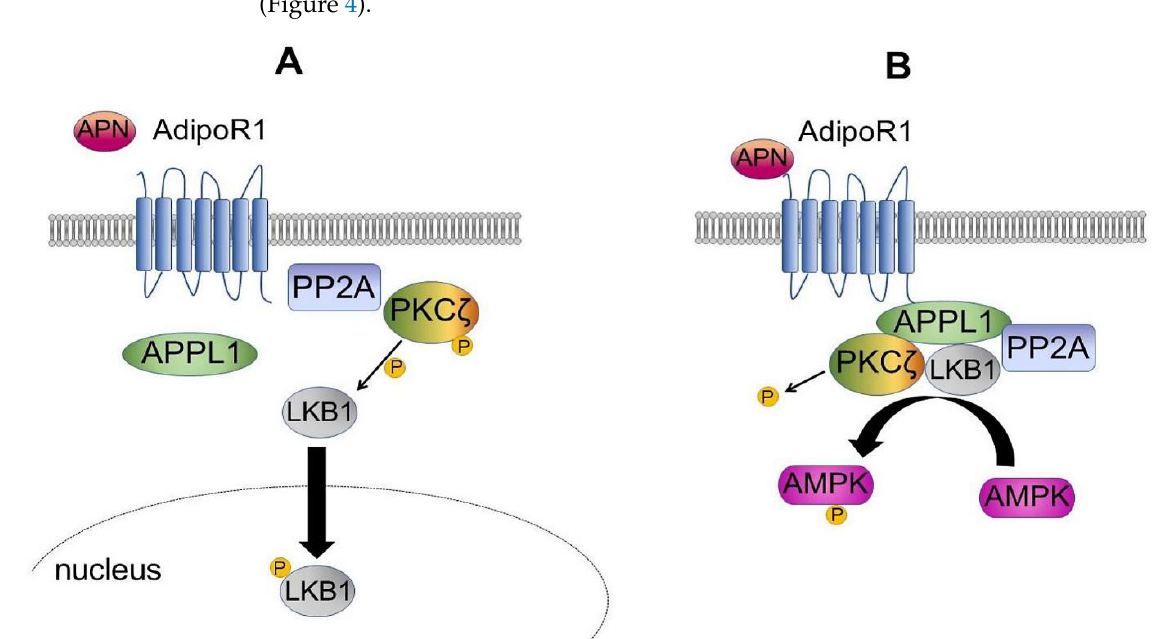
Figure 4. PVAT control vascular function by mean of precise mechanism related to adiponectin- dependent AMPK activation. Two conditions are relevant. ( A ) non-stimulated with no link between adiponectin (APN) and Adiponectin receptor 1 (AdipoR1). Adaptor protein, phosphotyrosine interacting with PH domain and leucine zipper 1 (APPL1) do not work alongside protein phosphatase 2A (PP2A). Protein kinase Cζ (PKCζ) induces phosphorylation of liver kinase B 1 (LKB1) affecting its translocation to the nucleus. ( B ) The stimulated state induces the bind of APN to AdipoR1 with activation of APPL1 resulting in PKCζ dephosphorylation by P. Dephosphorylated PKCζ is no longer effective to phosphorylate LKB1. PP2A also dephosphorylates LKB1, which results in LKB1 translocation to the cytoplasm. LKB1 phosphorylates AMP-activated protein kinase (AMPK) in the form of the AdipoR1/APPL1/PP2A/ PKCζ/LKB1 complex. Abbreviations are in the text.